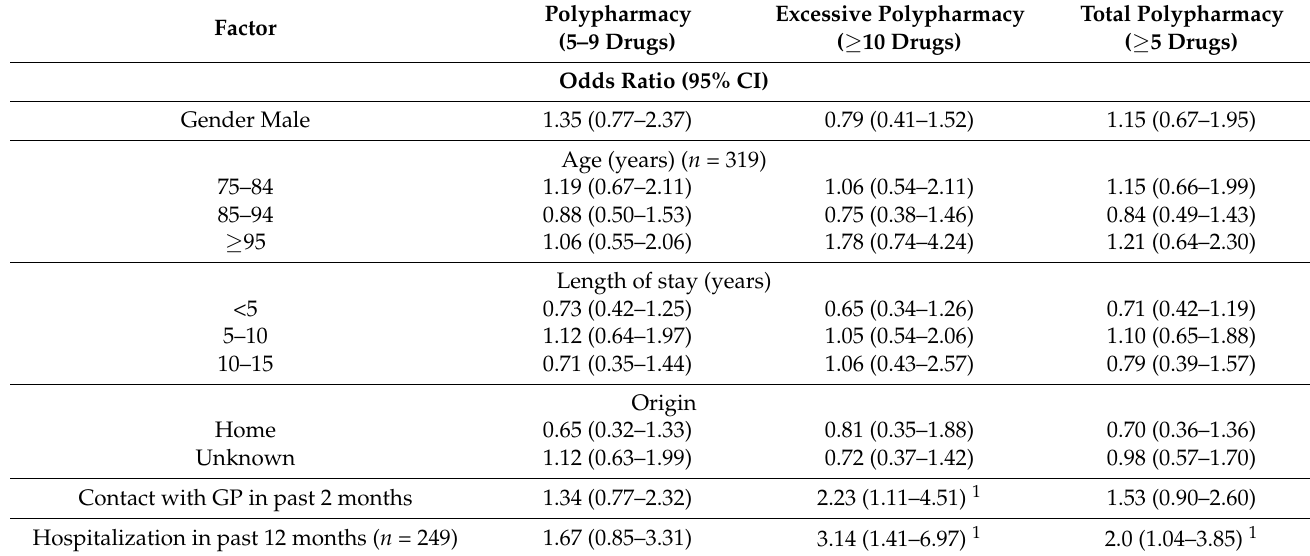
Table 2. Factors associated with polypharmacy among residents in the NH studied (reference category: non-polypharmacy). Polypharmacy Excessive Factor (5–9 Drugs)